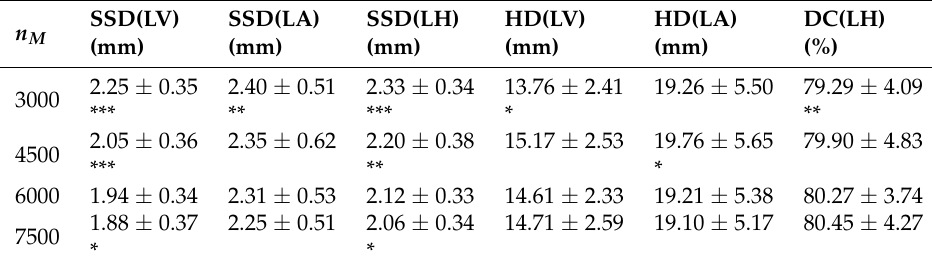
Table 3. Segmentation results of group-wise separate according to vertex number of 3D model n M . This result is calculated with 35 cases under six-fold